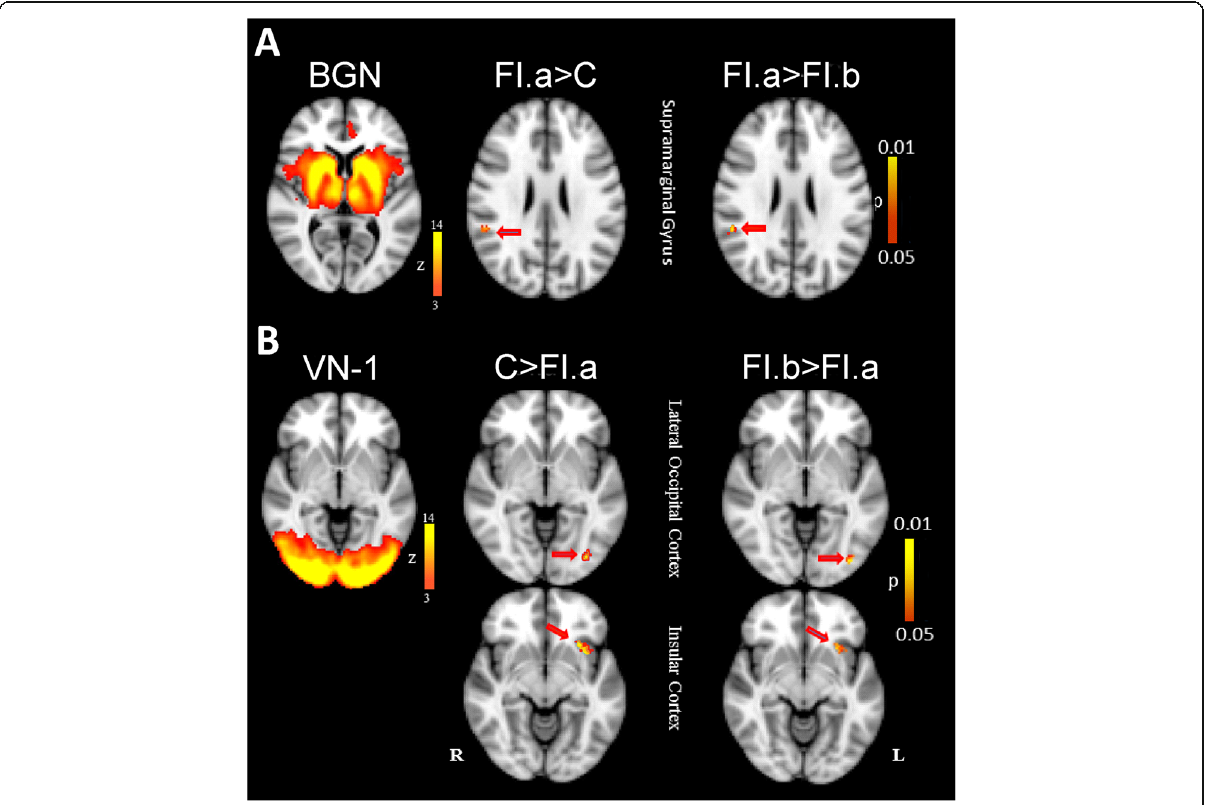
Fig. 2 a basal ganglia network (BGN, left); between group comparison comparing FI before training (FI.a) and control group (C) (middle); training effect comparing FI before (FI.a) and after (FI.b) training (right). b Visual Network-I (VN-1, left column); between group comparison comparing FI before training (FI.a) and control group (C) (middle); training effect comparing FI before (FI.a) and after (FI.b) training (right). All data are FWE- corrected for multiple comparisons ( p < training (Fig. 3, Table 5): training increased the connect- ivity between anterior DMN and left amygdala/right hippocampus and between VAN and left thalamus. However, we found a significant decrease of connectivity between LFPN and right thalamus and between ventral DMN and right putamen/right Ncl. accumbens.